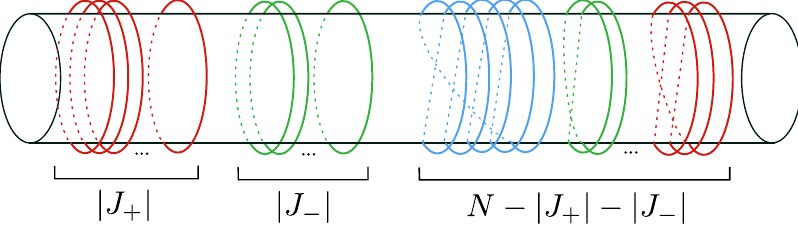
Figure 4 . A typical state with positive J (cid:6) (cid:24) O ( N ). The red strings carry ( J + ; J (cid:0) ) = (1 ; 0) and the green strings carry ( J + ; J (cid:0) ) = (0 ; 1). The freedom to pick any colored partition of the remaining N (cid:0) j J + j (cid:0) j J (cid:0) j elements gives rise to the entropy